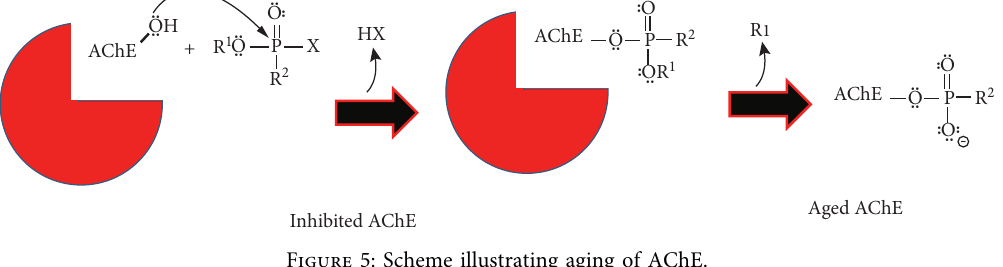
Figure 5: Scheme illustrating aging of AChE.